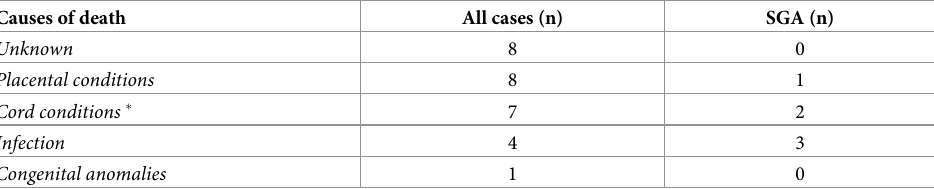
( � ) three cases with more than 3 neck loops, two cases with 2 tight cord neck loops 1 true cord knots, one